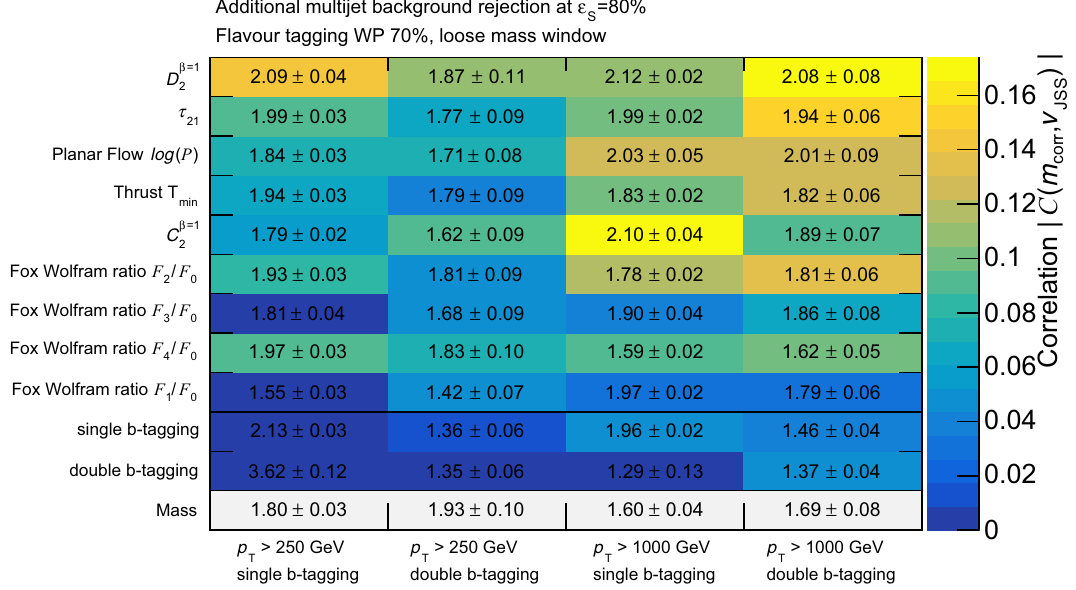
coefficient, | C ( m corr ,v JSS ) | , between the jet mass and the jet substruc- turevariables.Theselectionefficiencyisdeterminedrelativetothemass window and b -tagging benchmark working points defined in Sects. 6.3 and 6.2 respectively